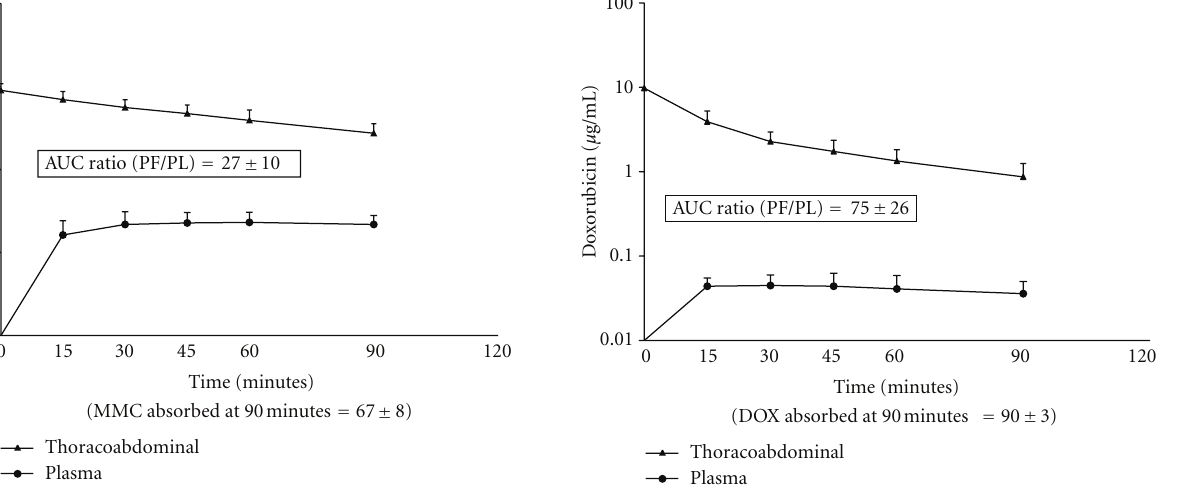
Figure 2: Pharmacokinetics of doxorubicin in 12 patients with simultaneous intraabdominal and intrathoracic chemotherapy administration in conjunction with cytoreductive surgery.